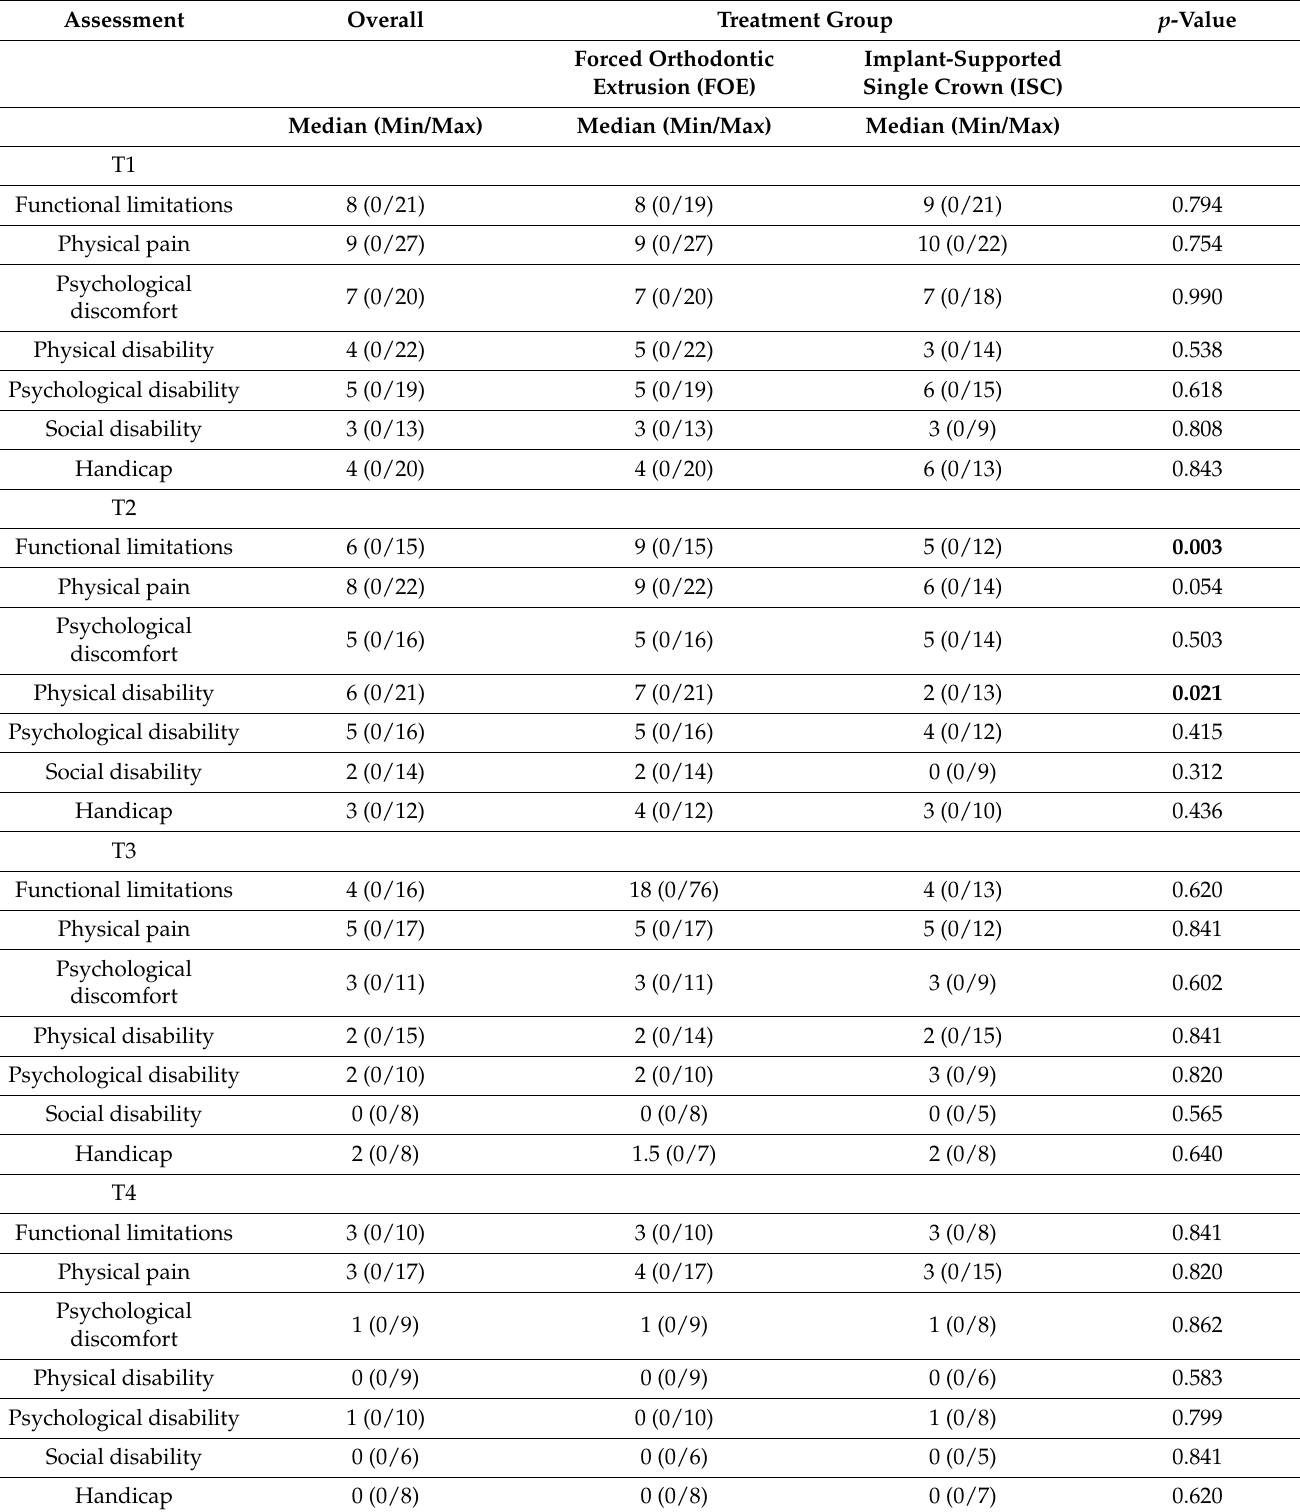
Table 3. Oral health-related quality of life (OHRQoL) in mean OHIP dimensions at time intervals T1–T4 for both treatment